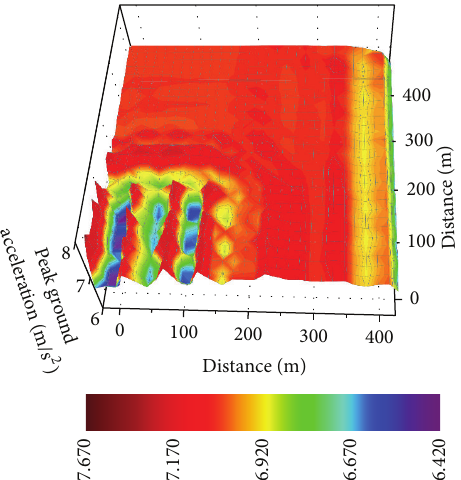
Figure 18: Peak ground acceleration distribution of URBAN6-6 (1/4 FE model, 𝐷 = 1.25 , El Centro, 𝑆𝑋